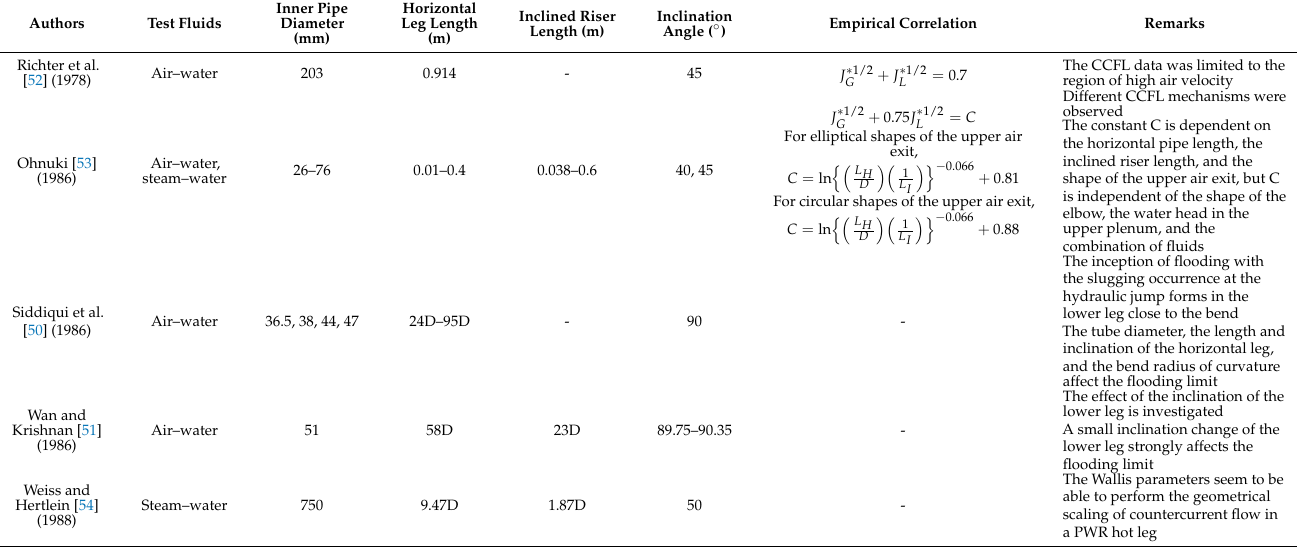
TheWallisparametersseemtobe abletoperformthegeometrical scalingofcountercurrentflowin